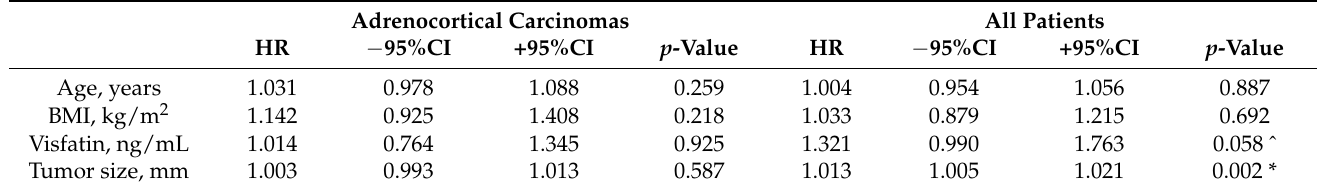
Table 6. Hazard ratios for predictors of mortality risk in the univariate Cox regression.